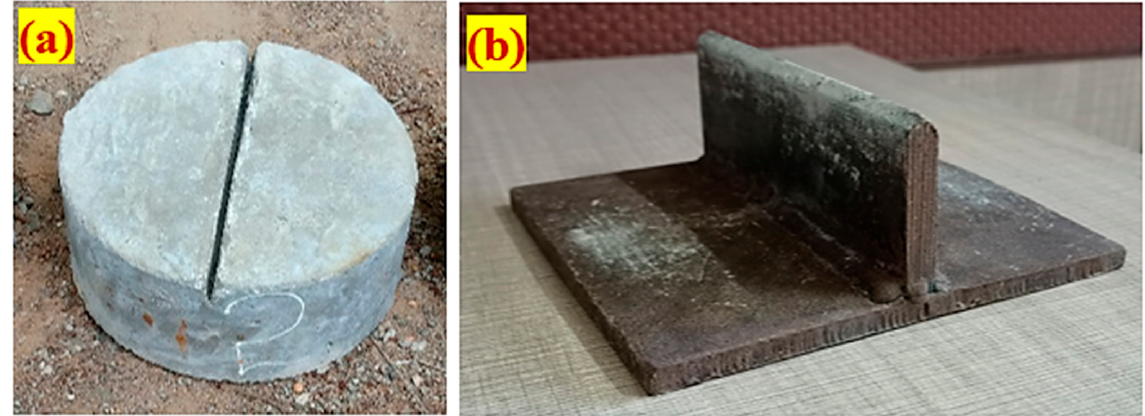
Figure 2. Modification proposed ( a ) Notched specimen, ( b ) Line-load transmitting plate.